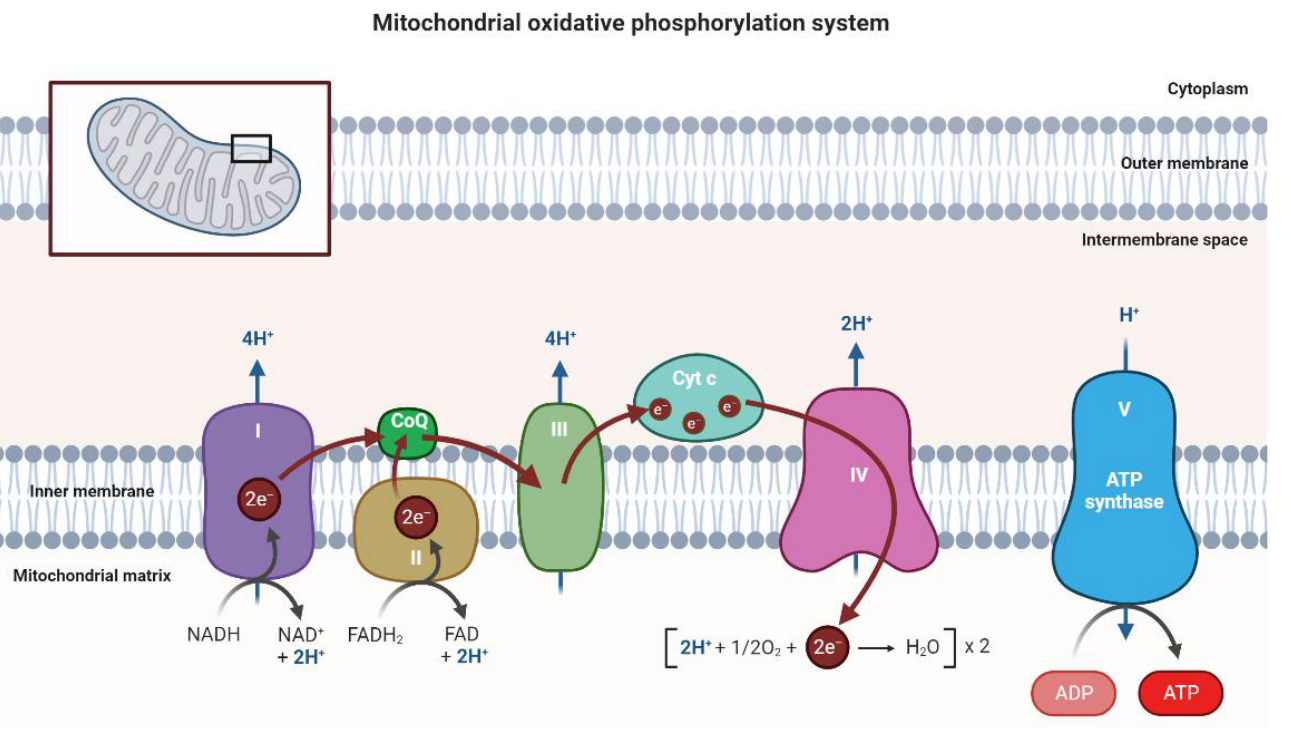
Figure 1. Schematic representation of the OXPHOS system composed of five large complexes and functional proteins such as CoQ and Cyt c located in the inner mitochondrial membrane, where the flow of electrons and protons through the respiratory chain is observed and where ATP synthesis occurs. Image created at BioRender.com.